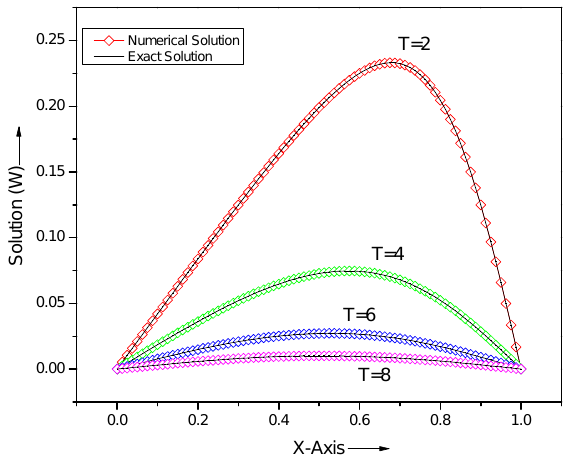
Figure 8. Comparison of analytical and numerical results for problem 5.2 at different times T , ν d = 0.1, ∆ x = 0.0125 and τ = 0.001.